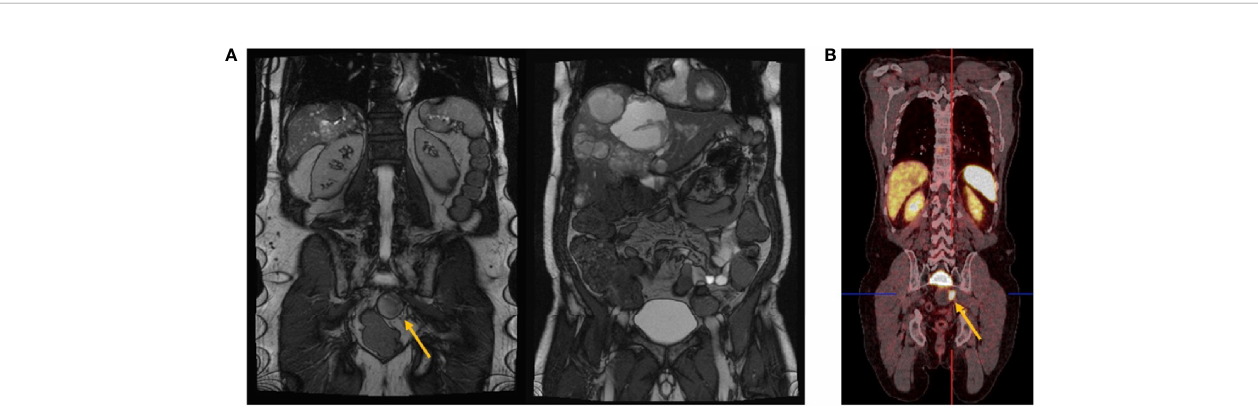
FIGURE 1 | (A) Magnetic resonance imaging. Coronal view demonstrating primary presacral neuroendocrine neoplasm (yellow arrow) and liver metastases. (B) Coronal view of a 68Ga-DOTATOC-PET/CT scan showing SSTR expression of the whole body. While the liver metastases showed a homogeneous SSTR expression, only a part of the presacral lesion showed a homogeneous SSTR expression (yellow arrow), suggesting a SSTR-negative/cystic portion besides the SSTR-positive solid presacral NEN. MRI and 68-DOTATOC-PET/CT are from the same patient (study-ID III) at different time